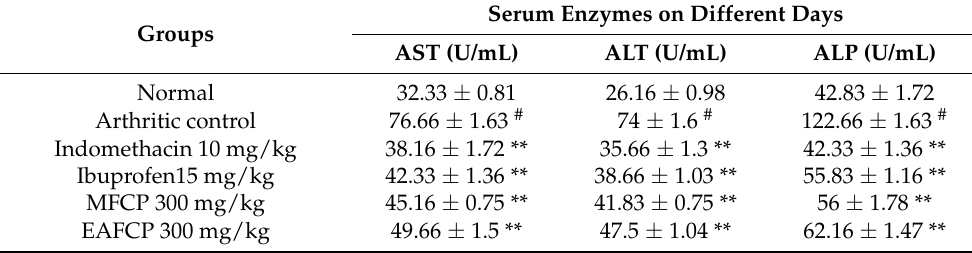
Table 4. Serum lysosomal enzyme in FCA-induced